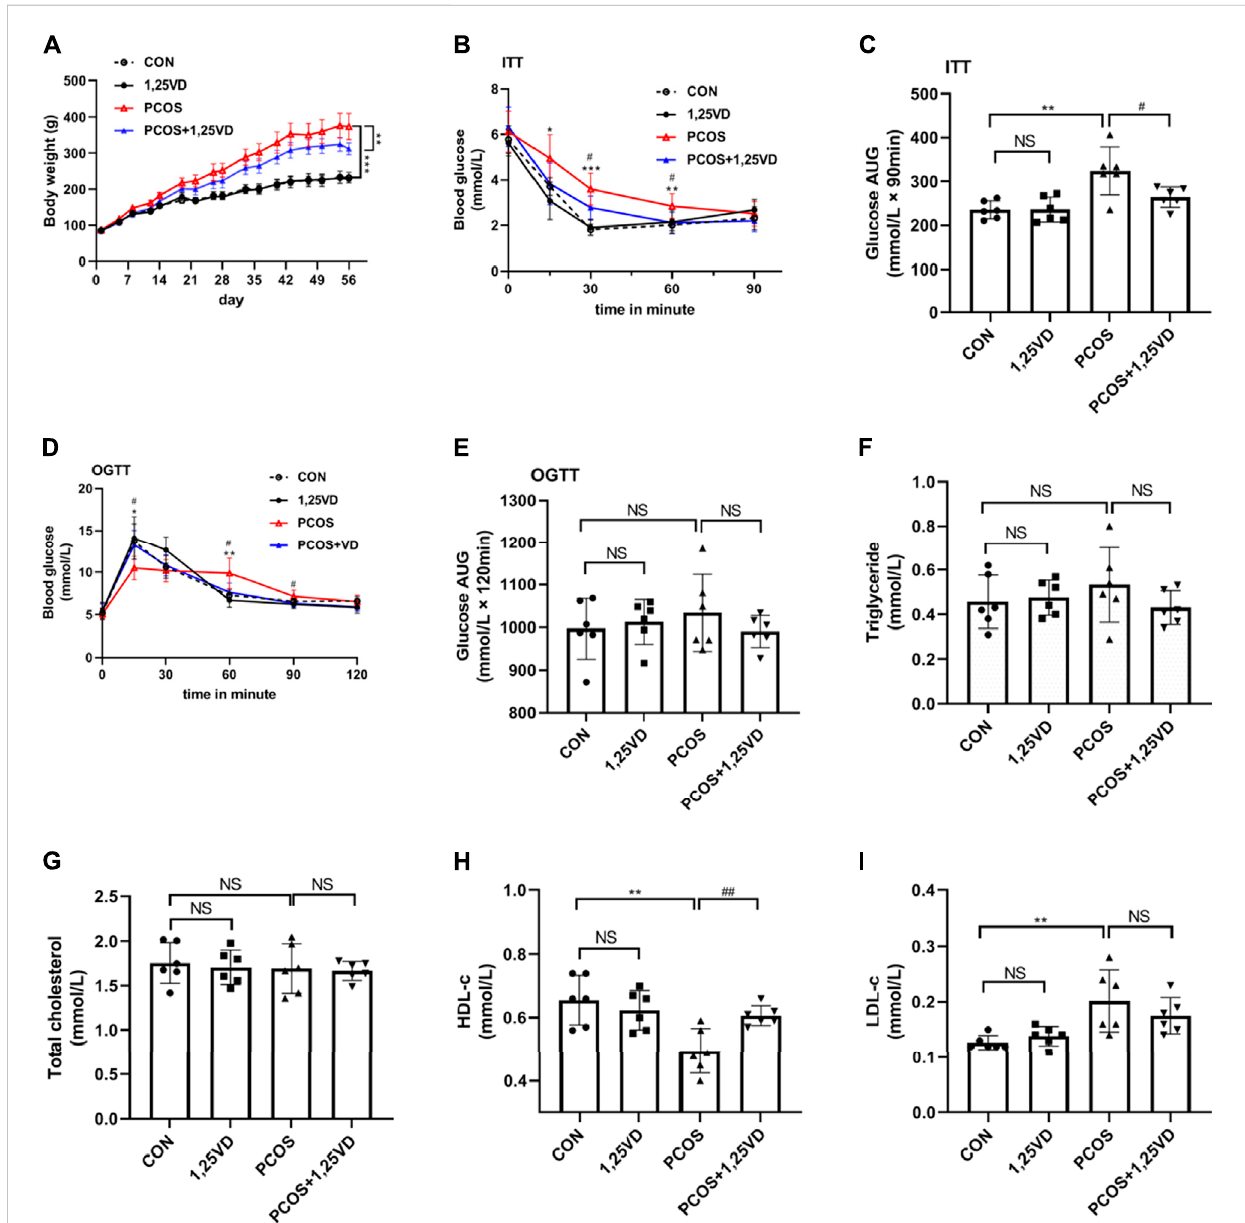
FIGURE 3 Comparison of the body weight (A) , ITT (B) , area under the curve (AUC) for glucose in ITT (C) , OGTT (D) , AUC for glucose in OGTT (E) , serum triglyceride levels (F) , total cholesterol levels (G) , HDL-c levels (H) and LDL-c levels (I) among the study groups. *: PCOS vs . CON p < 0.05, **: PCOS vs